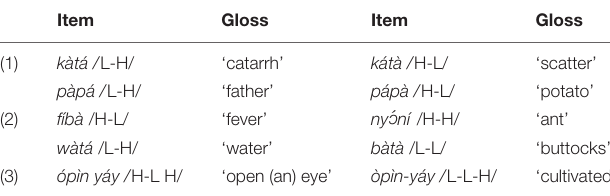
TABLE 2 | Multisyllabic tonal minimal pairs in